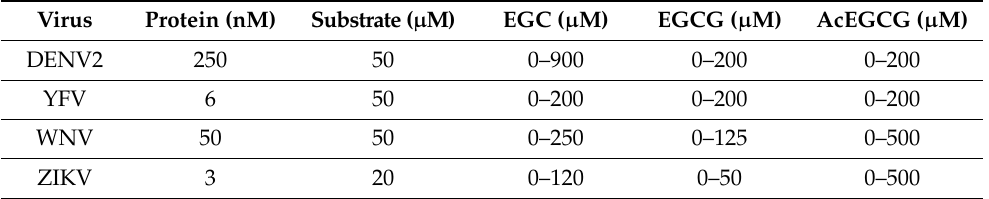
Table 1. Protein, substrate, and epigallocatechin molecules concentration used in the activity assay.